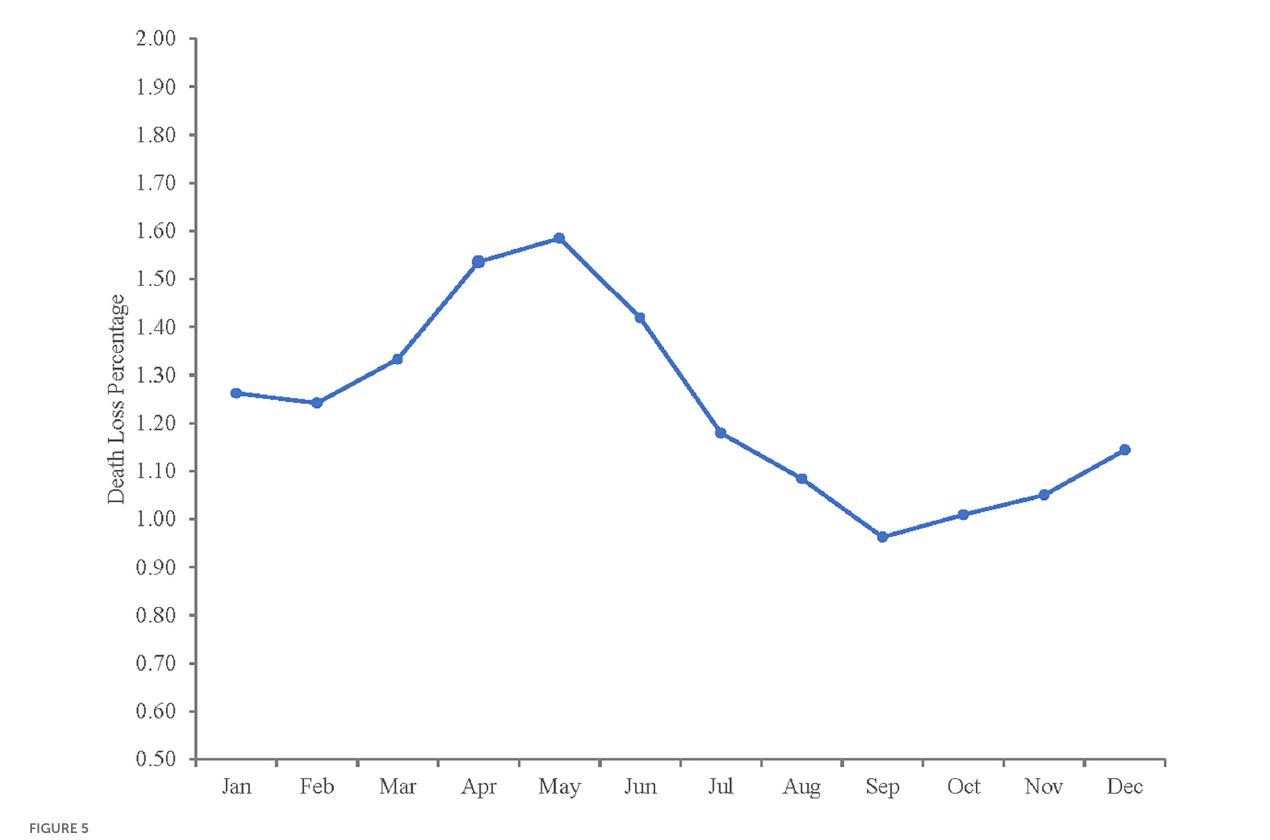
FIGURE5 Seasonal pattern of death loss percentage from estimated